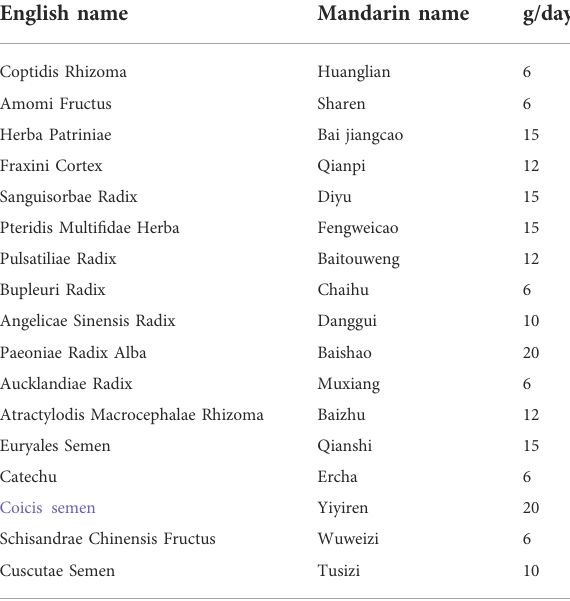
TABLE 1 The composition and clinical dosage of